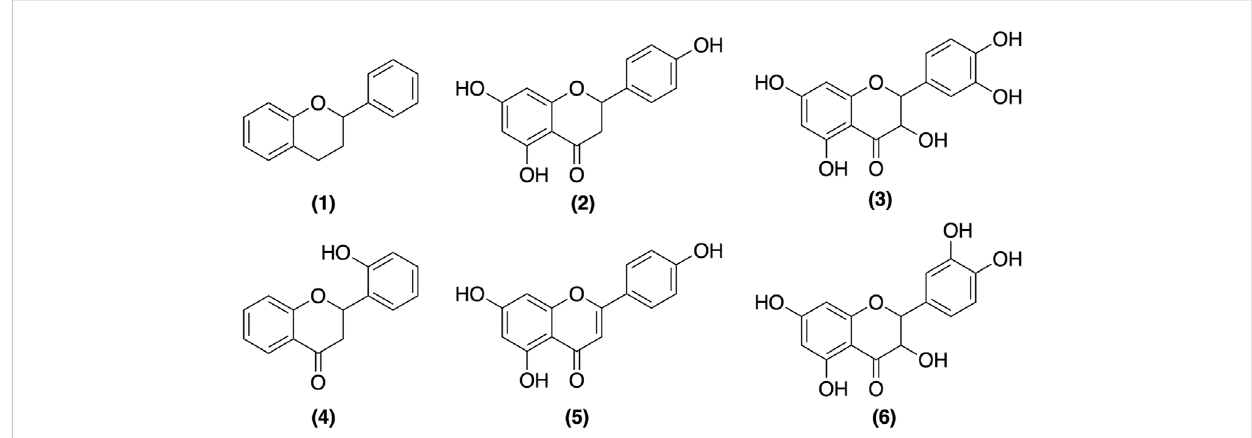
FIGURE 1 Chemical structures of representative Flavonoids (1) Flavonoids basal structure (2) Naringenin — fl avanone (3) Taxifolin — fl avanonol (4) 2 ′ -hydroxy fl avanone — fl avanone (5) Apigenin — fl avone and (6) Quercetin — fl avonol.